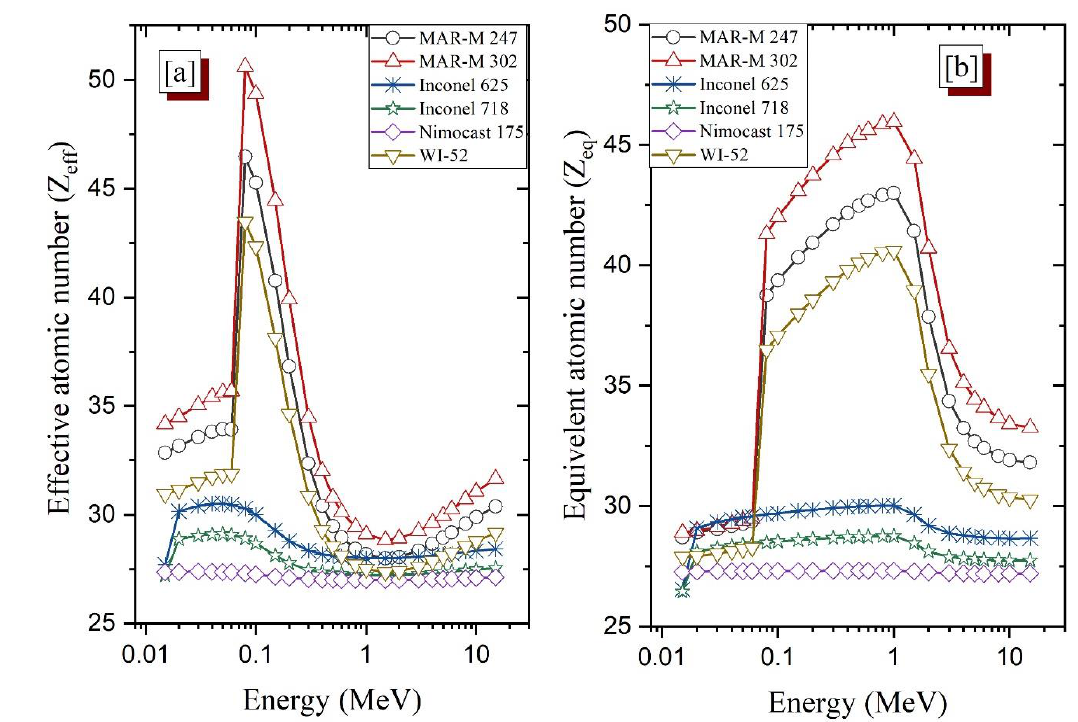
Figure 5. Variation of the atomic number of the investigated alloys versus incident gamma-ray energy: ( a ) effective atomic number (Z eff ), ( b ) the equivalent atomic number (Z eq )